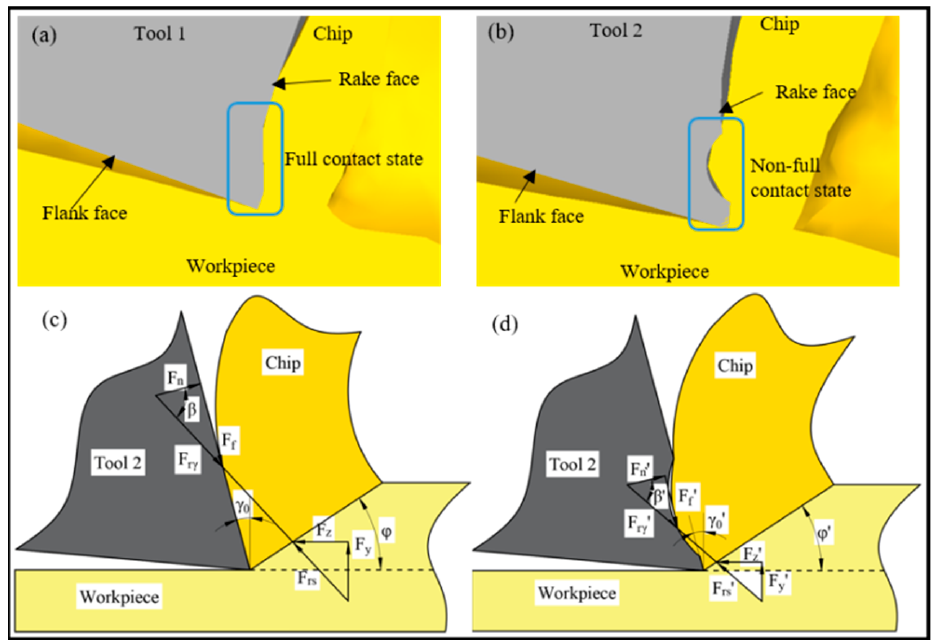
Figure 4. Comparison of tool–chip contact and force balance relationships for two tools: ( a ) the tool–chip contact of Tool 1, ( b ) the tool–chip contact of Tool 2, ( c ) the force balance relationship of Tool 1, ( d ) the force balance relationship of Tool 2.